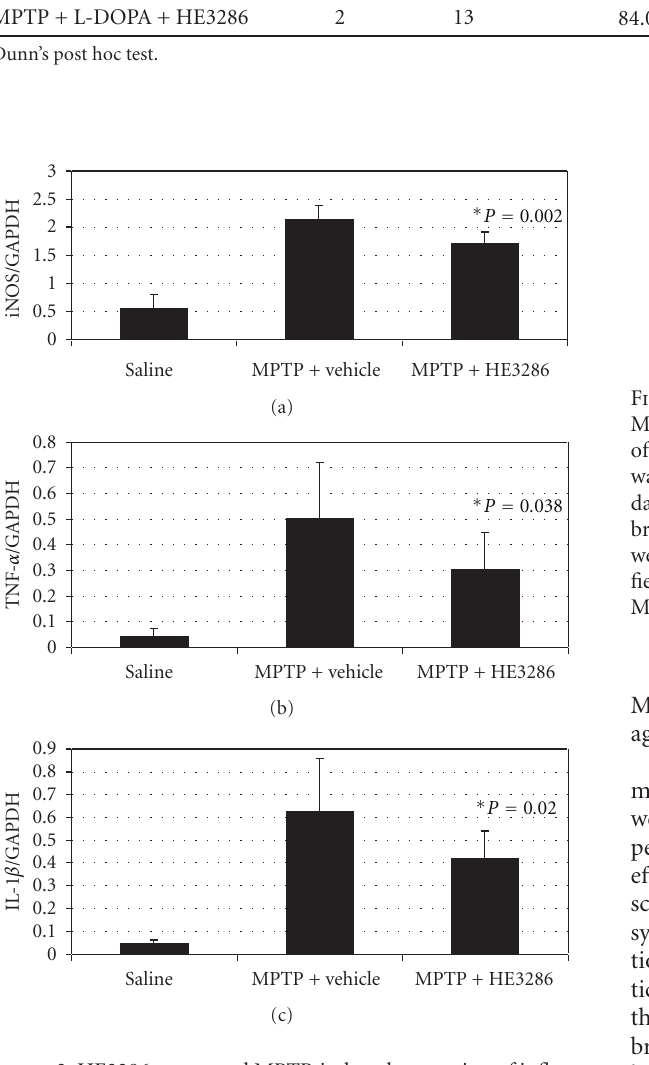
Figure 3: HE3286 attenuated MPTP-induced expression of inflam- matory cytokines. Mice (male, C57/Bl6 mice, 8 per group) received four injections of 20 mg/kg MPTP 2 h apart. HE3286 (40mg/kg), vehicle, or saline was administered by oral gavage twice-daily for four consecutive days beginning 1h after the last MPTP injection. Gene expression for iNOS (a), TNF- α (b), and IL-1 β (c) was assessed by semiquantitative reverse transcriptase-polymerase chain reaction. Gene expression data are presented as the ratio between target gene expression and GAPDH control gene expression. ∗ Sta- tistically significant compared to MPTP + vehicle by the Mann- Whitney test.